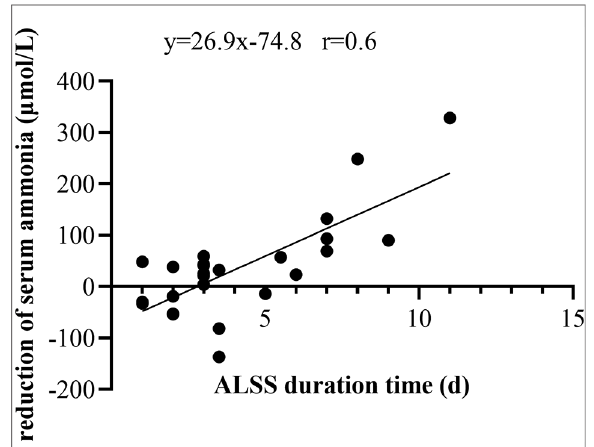
FIGURE 5 Correlation and linear regression between ALSS duration and reduction in serum